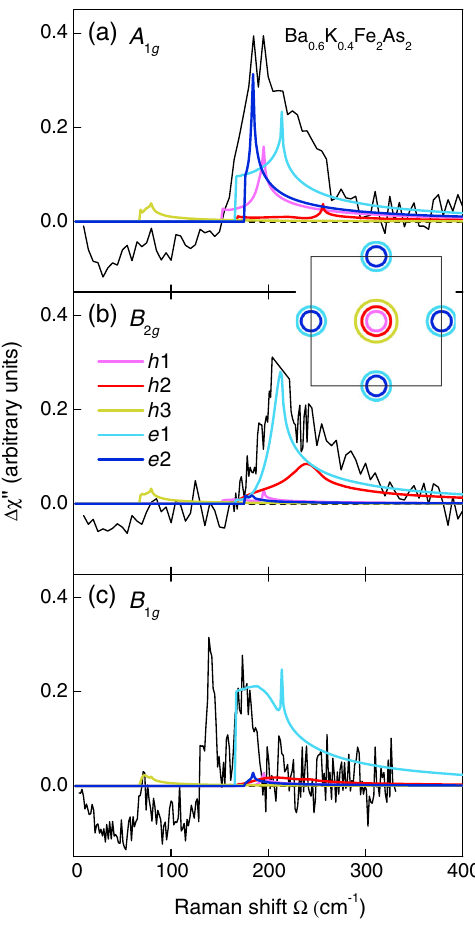
FIG. 5. Contributions of the different bands to the cross section. Shown are the individual contributions of the five bands h 1 – e 2 , as indicated in (b), to the total cross section, as displayed in Fig. 3, for (a) A 1 , (b) B 2 , and (c) B 1 symmetry. The inset shows a g g g sketch of the first BZ with the corresponding color code for the Fermi surfaces. The experimental data are shown in